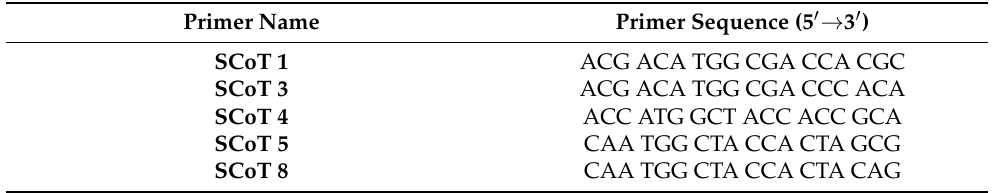
Table 1. SCoT primer codes and